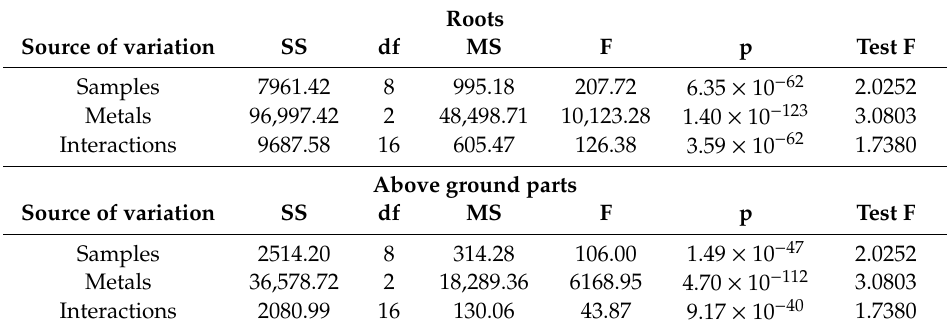
Table 1. Two-way ANOVA parameters* for Mn, Pb, and Zn contents in above ground parts and in roots of Melissa officinalis across eight soil supplementations as described in the Materials and Methods section.